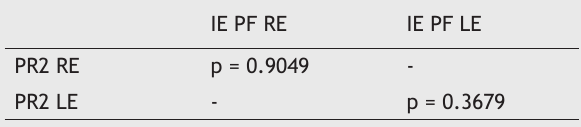
Table 3 Correlation between numerical